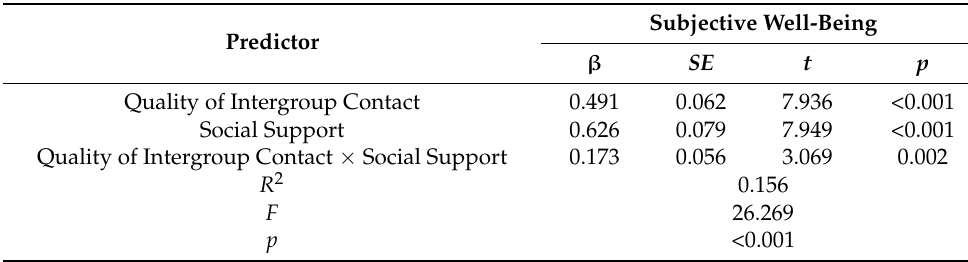
Table 4. Analysis of the moderating effect of perceived social support on the quality of intergroup contact and subjective